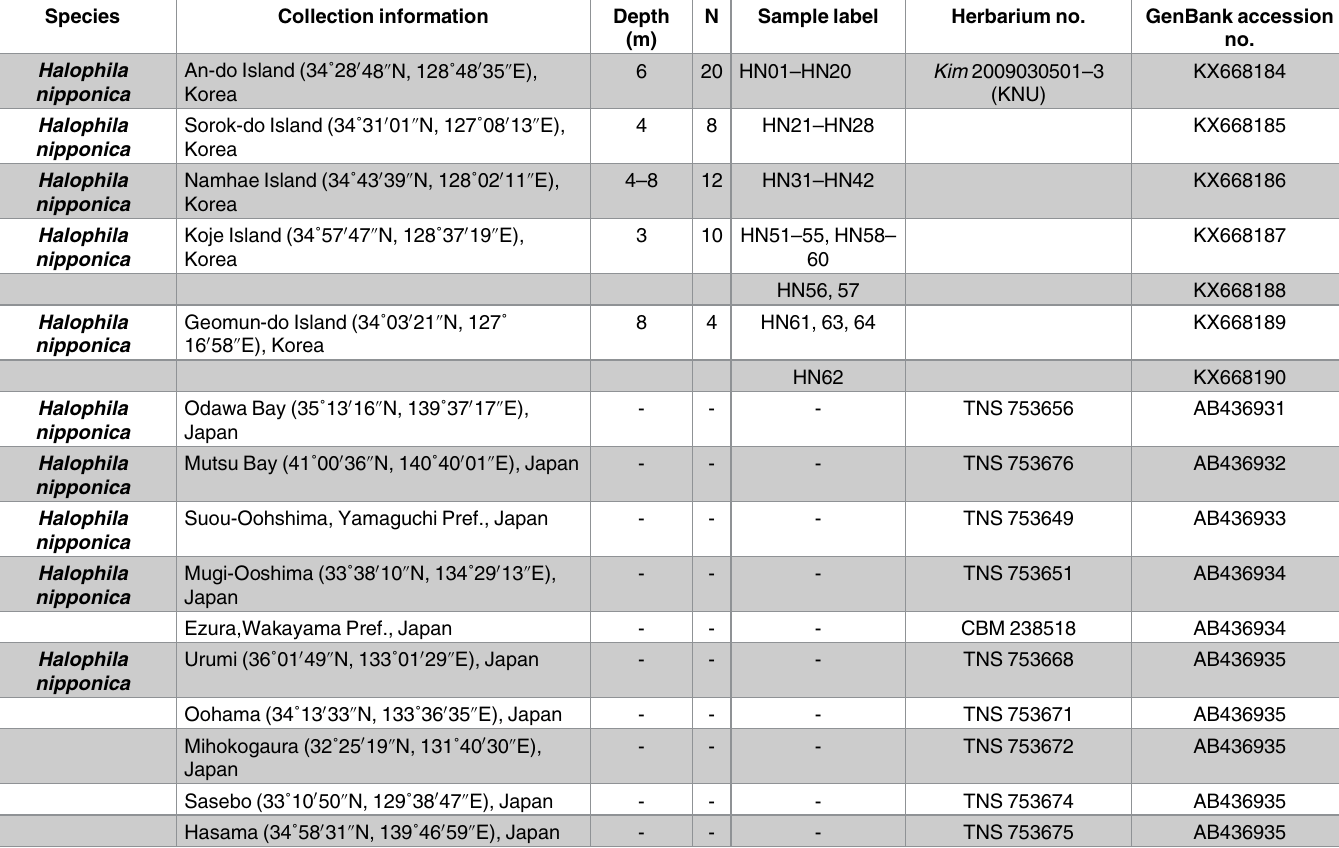
Table 1. Collection information and GenBank accession numbers of Halophila nipponica specimens used for phylogenetic analysis from various geographical locations in the temperatecoastal waters of northeast